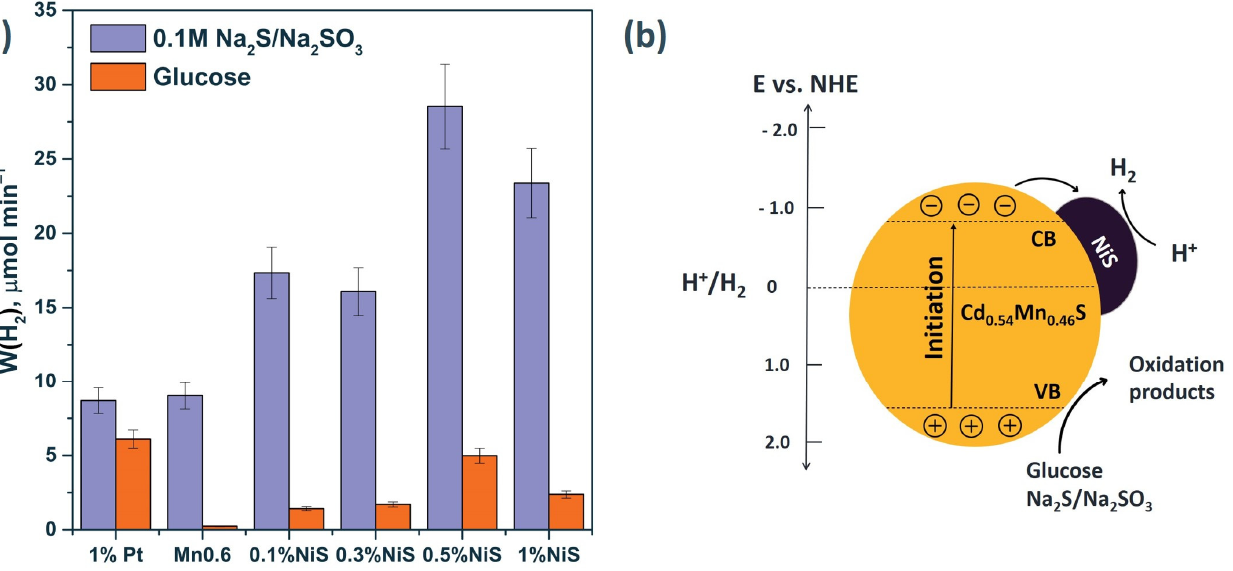
Table 3. The rate of photocatalytic hydrogen evolution for different photocatalysts. Experimental